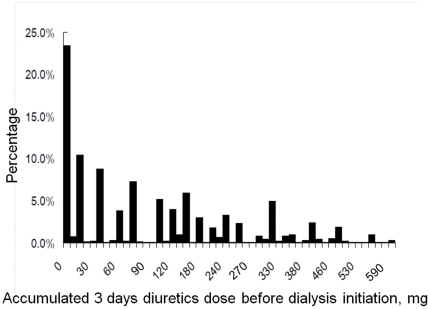
Histogram of accumulated 3-day diuretic use before dialysis initiation (equivalent of furosemide, mg).